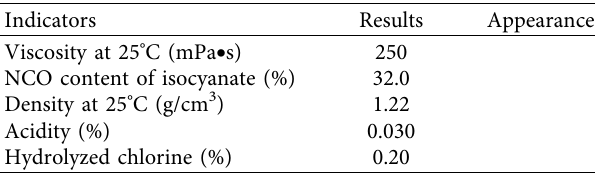
Table 1: PAPI technical indicators.